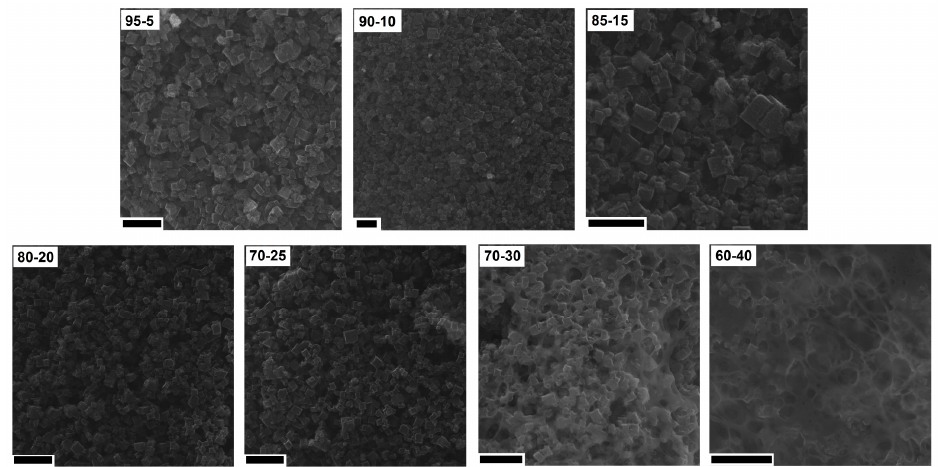
Figure 9. The SEM images of the electrodes prepared by evaporation with different ratios of CMOF-5:PVDF (scale bar 20